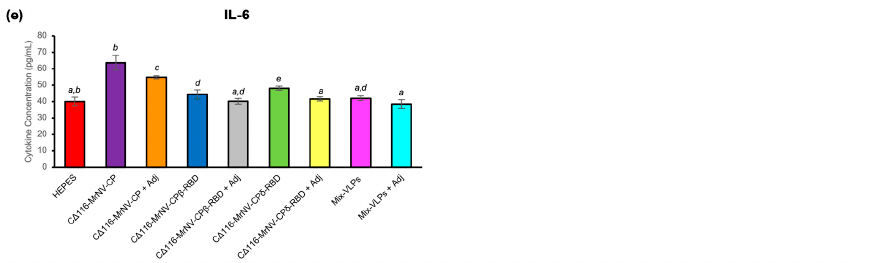
Figure 6. Multiplex quantification of cytokines in the sera of mice immunized with the chimeric VLPs. Different types of cytokines, ( a ) IFN- γ ; ( b ) IL-12p70; ( c ) TNF- α ; ( d ) IL-5; and ( e ) IL-6, collected from sera of the study groups, were quantitated. The negative groups were inoculated with HEPES buffer or the VLPs of C Δ 116- Mr NV-CP with and without the AddaVax adjuvant (Adj), while the test groups were inoculated with the VLPs of C Δ 116- Mr NV-CP displaying the β -SARS-CoV-2 RBD (C Δ 116- Mr NV-CP β -RBD ) and C Δ 116- Mr NV-CP displaying the δ -SARS-CoV-2 RBD (C Δ 116- Mr NV- CP δ -RBD ) and a mixture of C Δ 116- Mr NV-CP β -RBD and C Δ 116- Mr NV-CP δ -RBD (Mix-VLPs) with and without the AddaVax adjuvant. Statistical significance ( p < 0.001) is denoted by italic letters shown above the bars. Insignificant differences are indicated by the same letter. The asterisks indicate sig- nificant difference ( p < 0.001) by comparing the concentration of cytokines produced in the test groups with that from the mice immunized with Mix-VLPs supplemented with adjuvant. Standard deviations of triplicate measurements are shown by error bars.